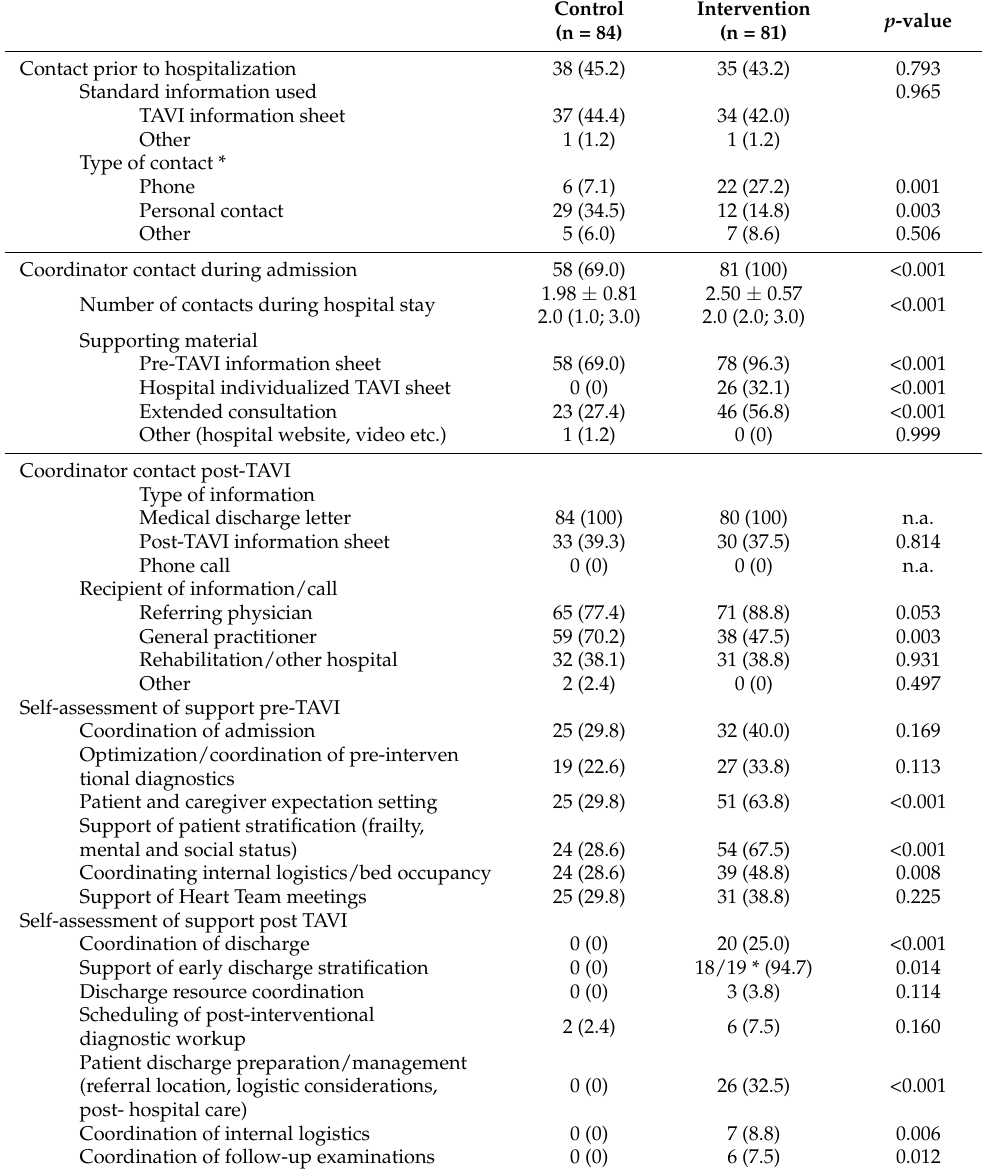
Table 4. Level of contact and coordinator self-assessment for pre- and post-TAVI periods, prior to (control phase) and after implementation of the TAVI coordinator (intervention